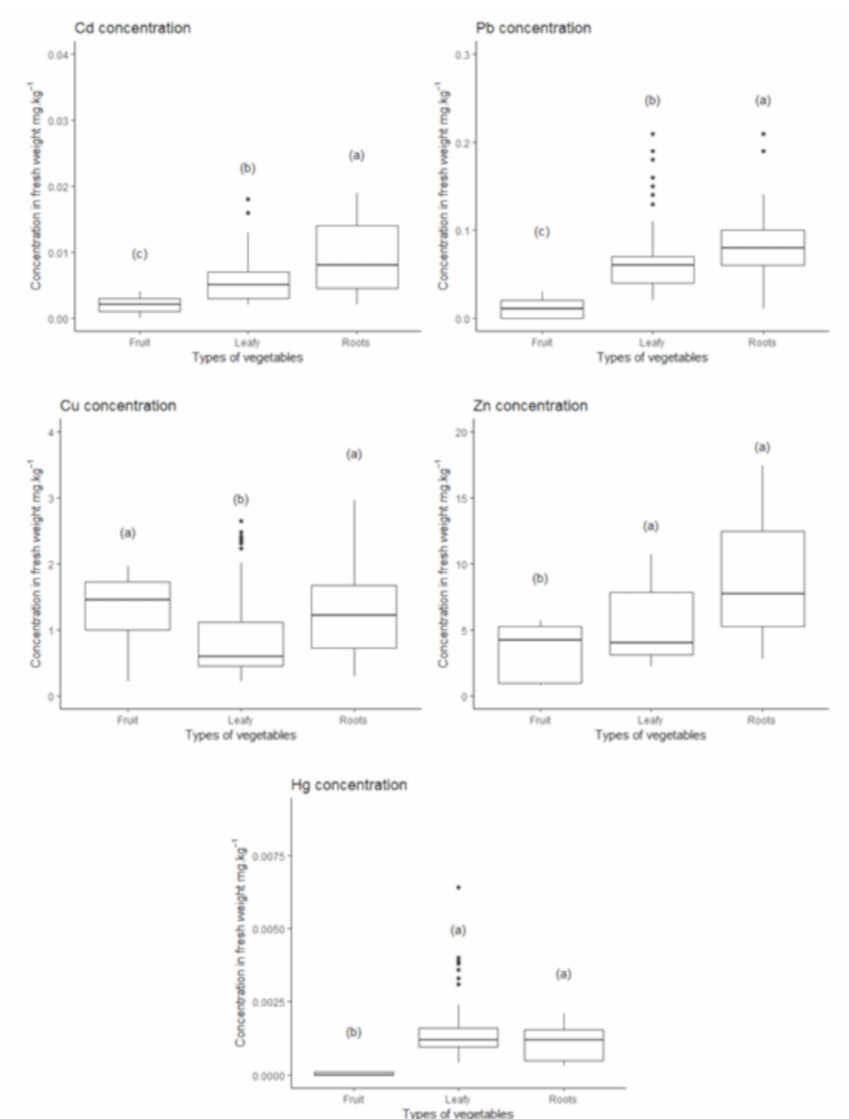
Table 1. Case study dealing with food production on rooftop. (a): [14]; (b): [2]; (c): [17]; (d): [18]; (e): [3]; (f): [19]; (g): [9]; (h): [20], (i): [21] and (j): [22]. LCA = Life Cycle